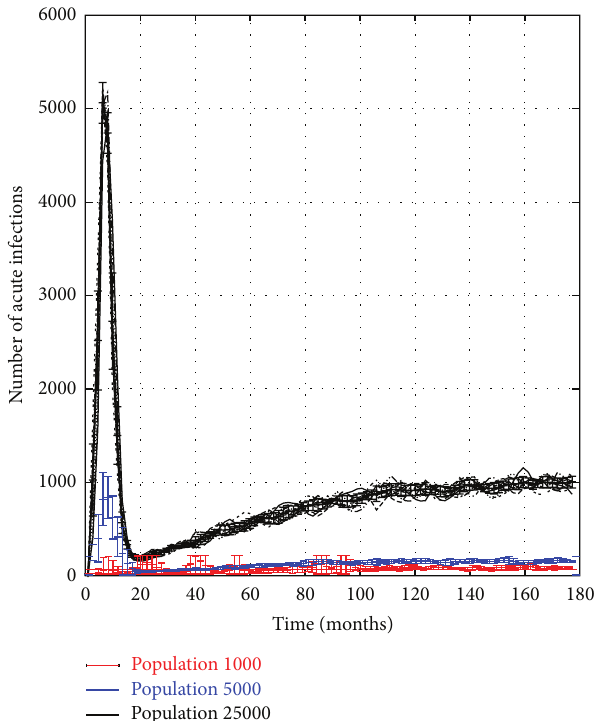
Figure 6: Number of acute HIV infections in PWID networks of size 1k–25 k